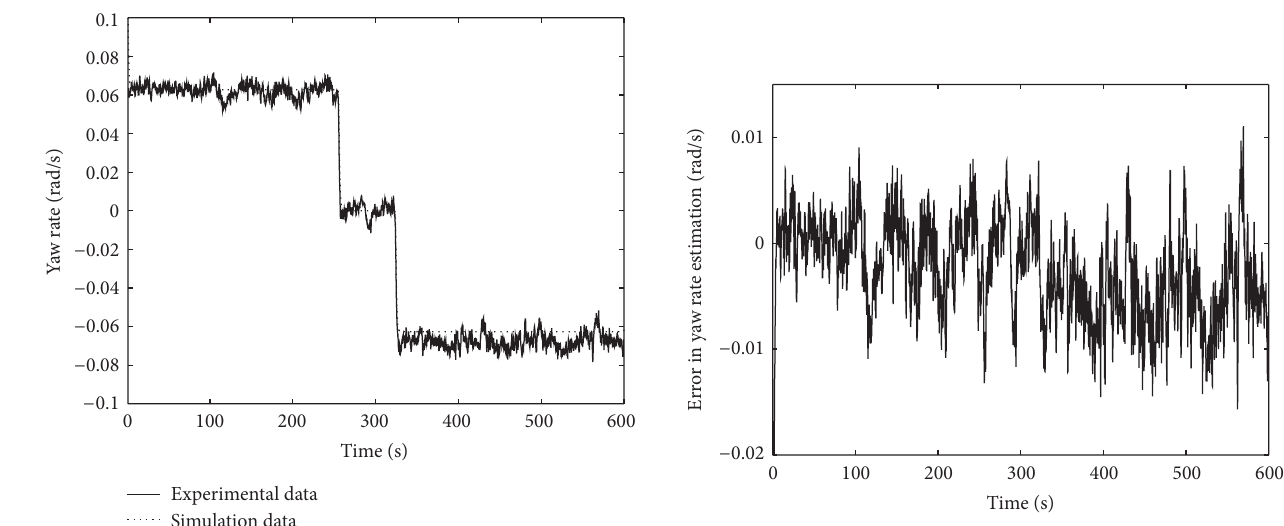
Figure 6: Yaw rate obtained in two consecutive turning manoeuvres with the ship (solid line) and in simulation (dotted line).